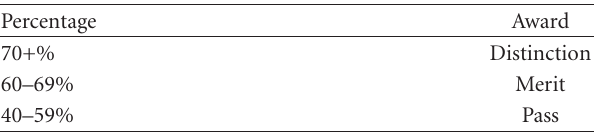
Table 3: Quality of